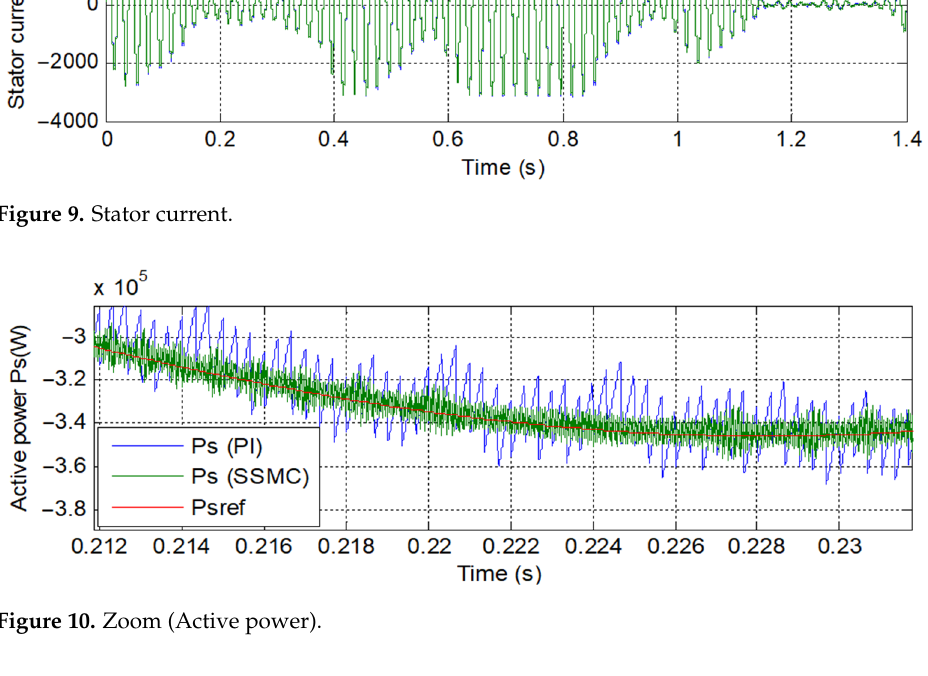
Figure 10. Zoom (Active power).